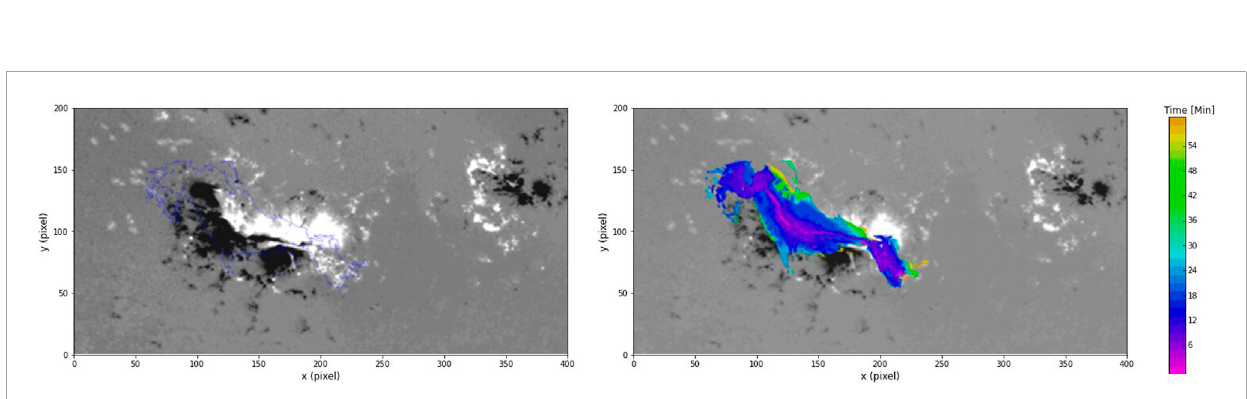
FIGURE 3 (Left) Contour of the cumulative area of flare brightening from flare start through 1 hour after flare overlaid on the 2012-03-07 00:00UT magnetogram. (Right) Evolution of flare brightening for the same time period.